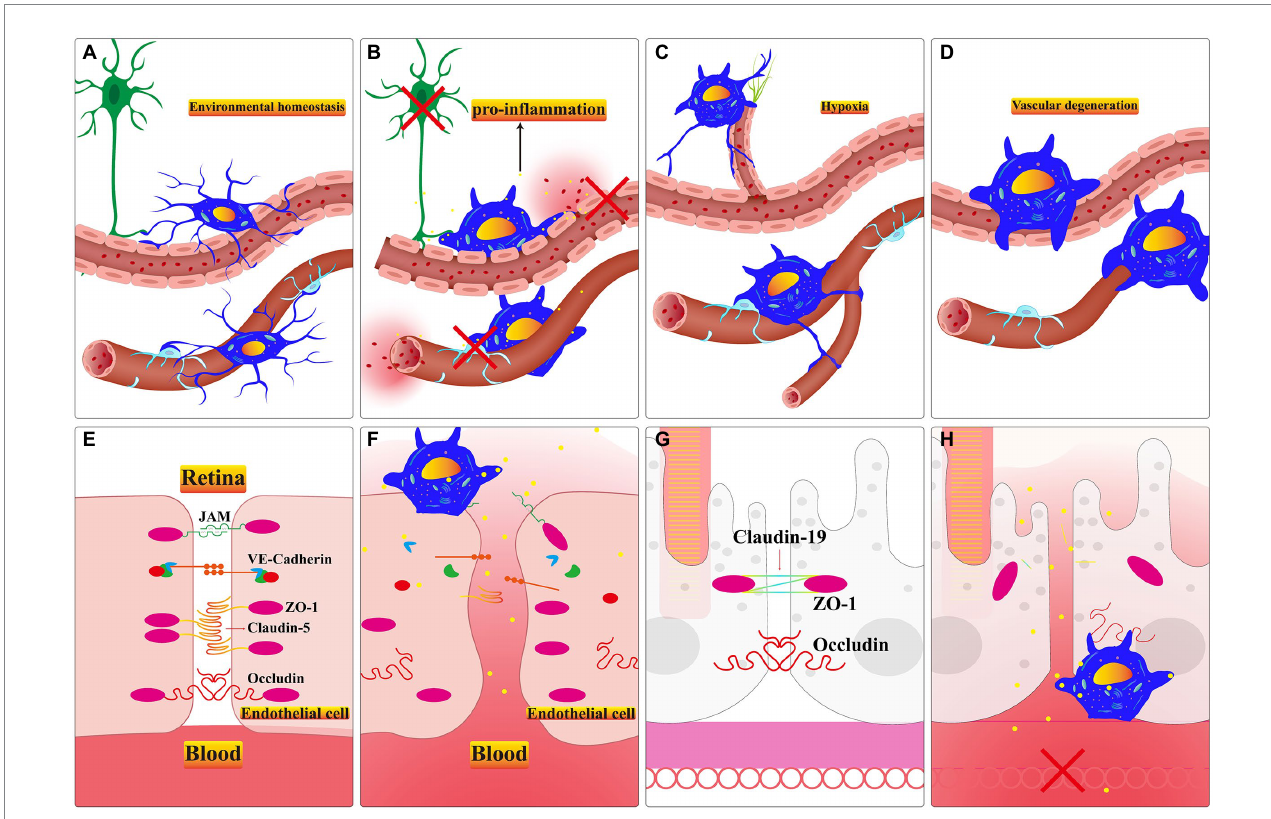
FIGURE 3 (A) Microglia monitor the retinal pericytes and endothelial cells and regulate the rate of retinal blood flow in healthy retina. B-D. The microglial responses in different retinal dysfunction environments. (B) Activated microglia promote apoptosis of neuronal cells, endothelial cells, and pericytes. Persistent activation of microglia alters the permeability of endothelial cells and promotes the appearance of vascular leakage. (C) Microglia guide the formation of neovascularization when the retina stays in a comparatively hypoxic environment. (D) In an inflammatory environment, activated microglia phagocytose the neovascular plexus or engulf apoptotic endothelial cells. (E) The major types of tight juctional molecules between endothelial cells of the iBRB in healthy retina. (F) Inflammatory factors secreted by activated microglia facilitate the downregulation of tight junctional molecules between endothelial cells, and vascular leakage occurs. (G) The significant types of tight junctional molecules between RPE cells of the oBRB in healthy retina. (H) Inflammatory factors secreted by activated microglia accelerate the downregulation of tight junctional molecules between RPE cells, capillary leakage, and RPE cells apoptosis. Choroidal neovascularization invasion to subretinal space in a relatively hypoxic